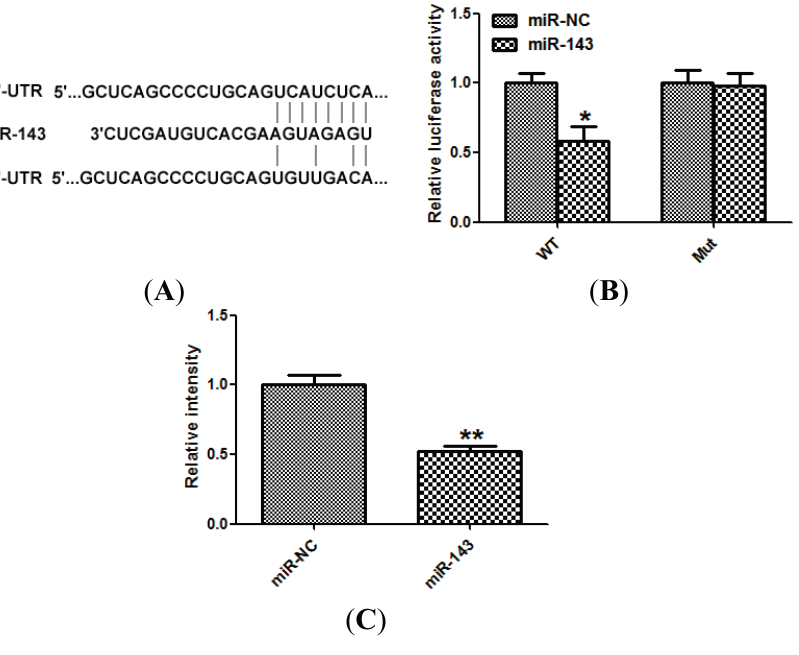
Figure 4. LIM domain kinase 1 (Limk1) is a direct target of miR-143 in NSCLC cells. ( A ) wild type Limk1 3'-untranslated regions (3'-UTR) (WT) or Mutated Limk1 3'-UTR (Mut) of Limk1 sequence; ( B ) HEK-293 cells were co-transfected with miR-143/miR-NC with WT/Mut 3'-UTR of Limk1. Relative luciferase activity was assayed; and ( C ) NCI-H23 cells transfected with miR-143 or miR-NC, and Western blot was used to detect the protein level of Limk1. Glyceraldehyde-3-phosphate dehydrogenase (GAPDH) was used as control. Experiments were performed in triplicate. * p < 0.05, ** p < 0.01 compared with